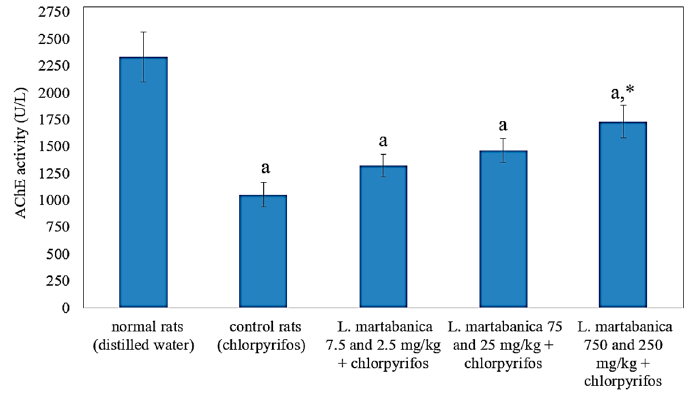
Figure 7. Effect of L. martabanica water extract on AChE activity. Values are expressed as mean ± S.E.M. a Significantly different from the normal rats, p < 0.05. * Significantly different from the control rats, p < 0.05, according to one-way ANOVA.